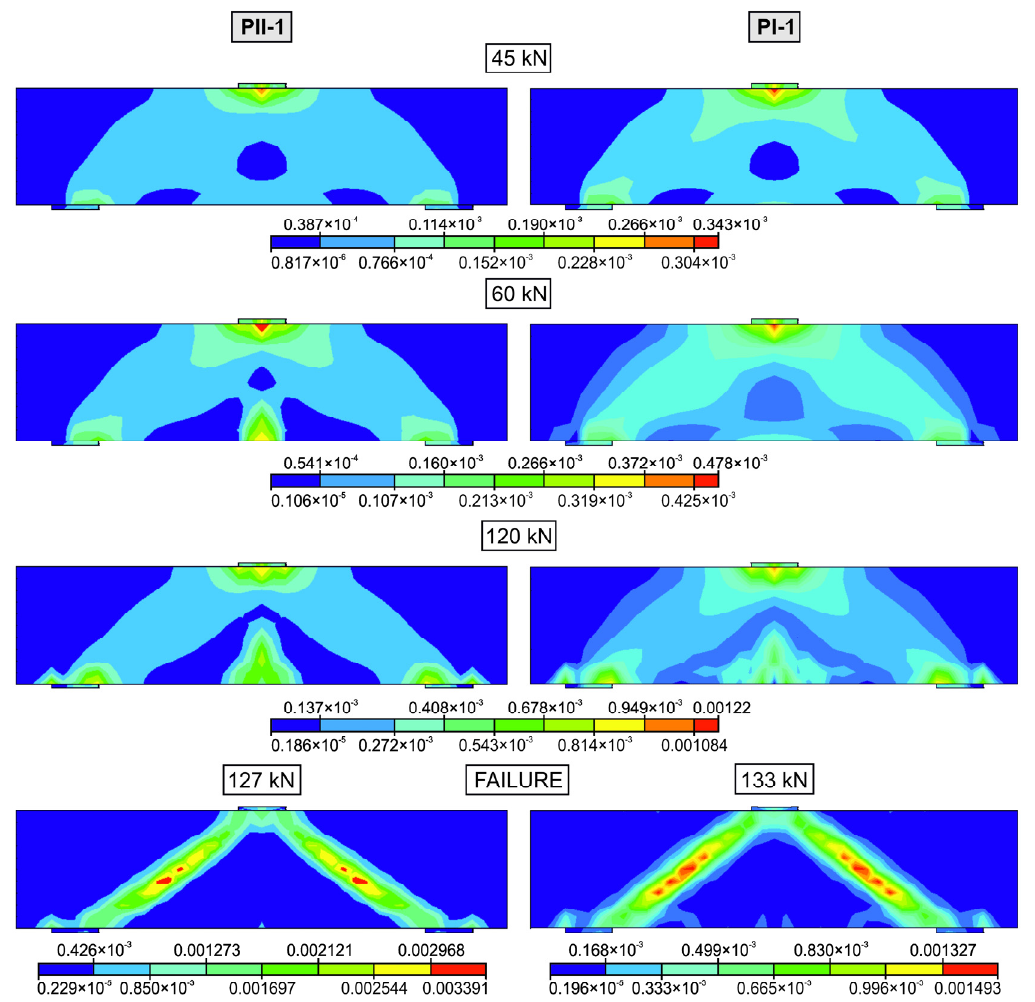
Figure 14. Comparison of strain intensity for the short beams PII-1 (2 φ 12, f y = 548 MPa) and PI-1 (2 φ 18, f y = 548